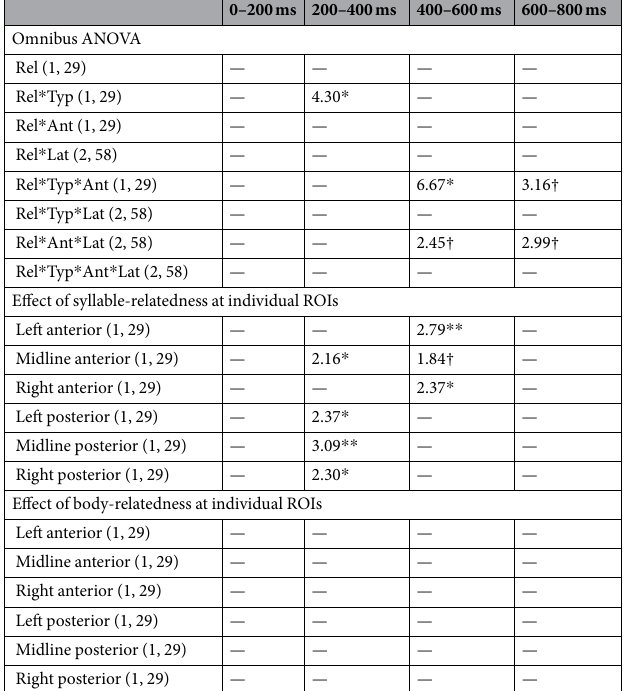
— — — — — Table 1. Summary of omnibus ANOVA and post hoc t test results on mean ERP amplitude. Ant: anteriority; Lat: laterality; Rel: prime-target relatedness; Typ: type of relatedness; —: non-significant F or t value, p ≥ 0.1. † p < 0.1, * p < 0.05, ** p <